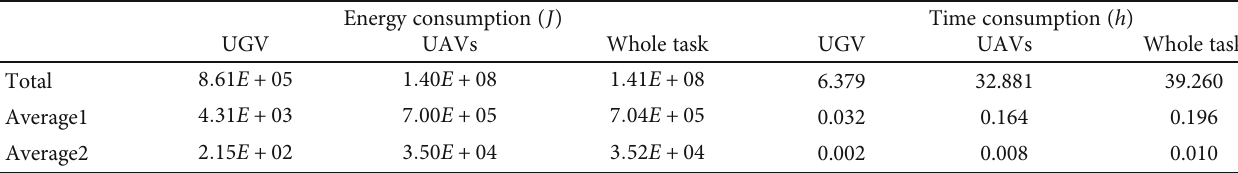
Table 4: The experimental results of a complex cooperative